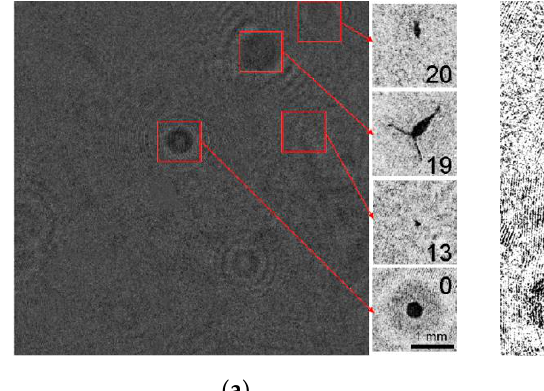
Figure 5. Example of the DHC data after processing in problem-oriented software at the AMK-82 station No. 6939. ( a ) Digital holograms and particle images reconstructed therefrom. The particle number is the ID number in Table 2. ( b ) A 2D view of the studied volume. ( c ) Patterning of the 2D view for particle recognition and classification (the color of the circumscribed rectangle indicates belonging to a particular taxon).